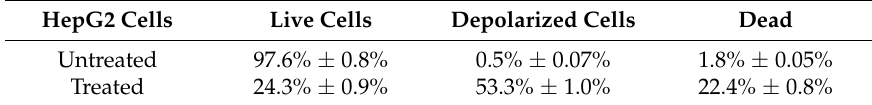
Table 3. Mitochondria membrane potential cells after treatment with 137 µ g/mL of PECS at 48